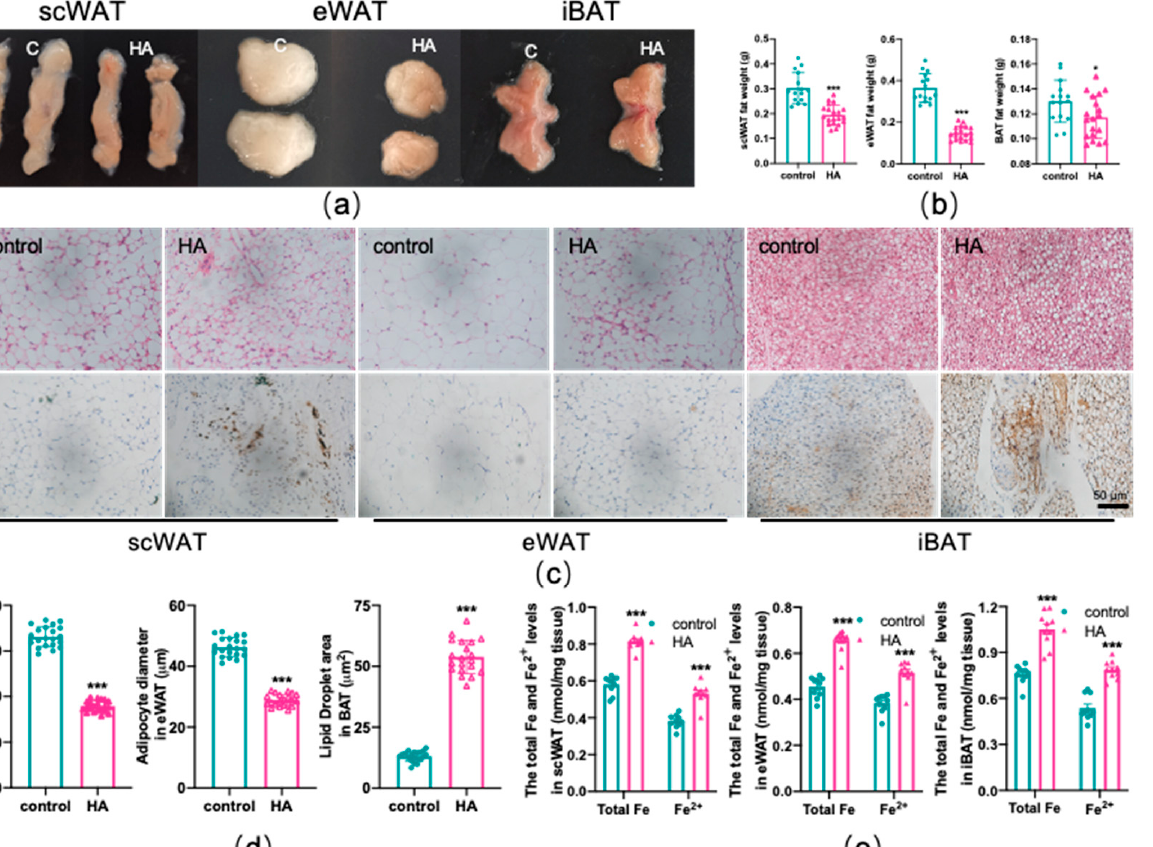
5 of 14 Figure 1. Hematological parameters and lipid profile differences induced by HA exposure. Graphs ( a – f ) display changes in hematological parameters. Graphs ( g – j ) display changes in lipid profiles.